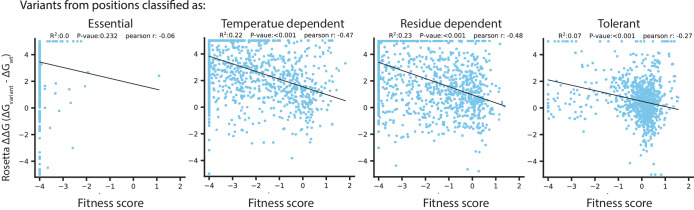
Rosetta ΔΔG in relation to temperature dependence classifications.In each plot, Rosetta ΔΔG is correlated with fitness score for amino acid variants from the catalytic domain, in positions with the temperature dependence classification indicated at the top.